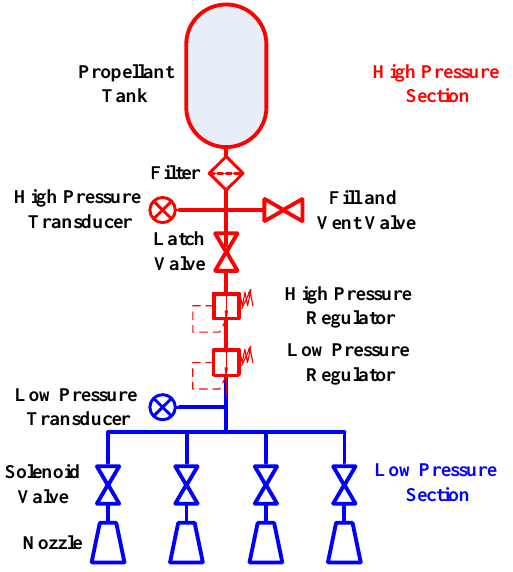
Figure 1. Schematic of the Adelis-SAMSON satellite cold gas propulsion system.